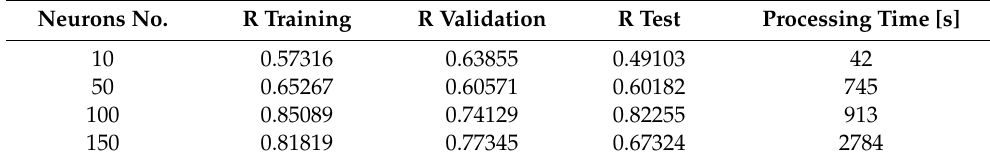
Table 2. Value R = f (neural network neurons).